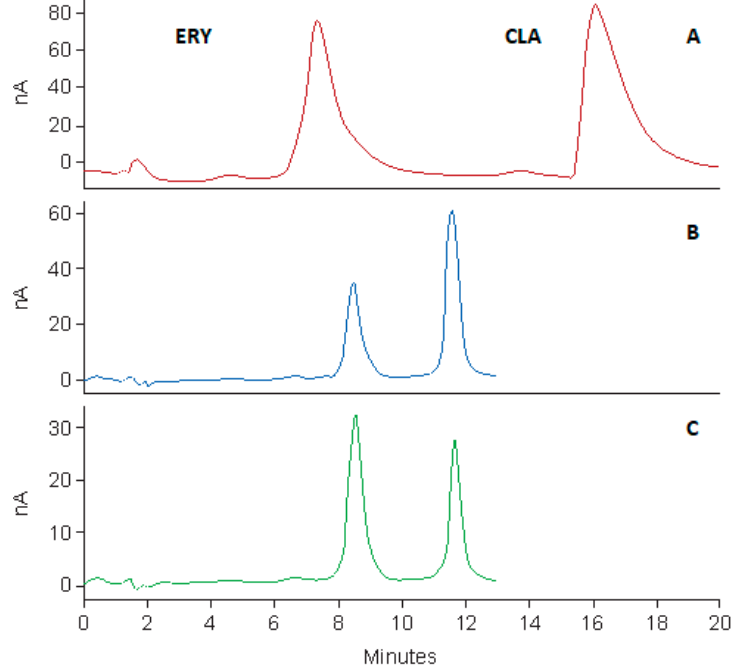
Figure 8. Typical chromatograms depicting the separation of CLA and ERY before method scaling (CLA 45 µg/mL, ERY 50 µg/mL) ( A ), after method scaling (CLA 50 µg/mL, ERY 50 µg/mL) ( B ) and for assay of Klarizon 250 mg tablets ( C ).